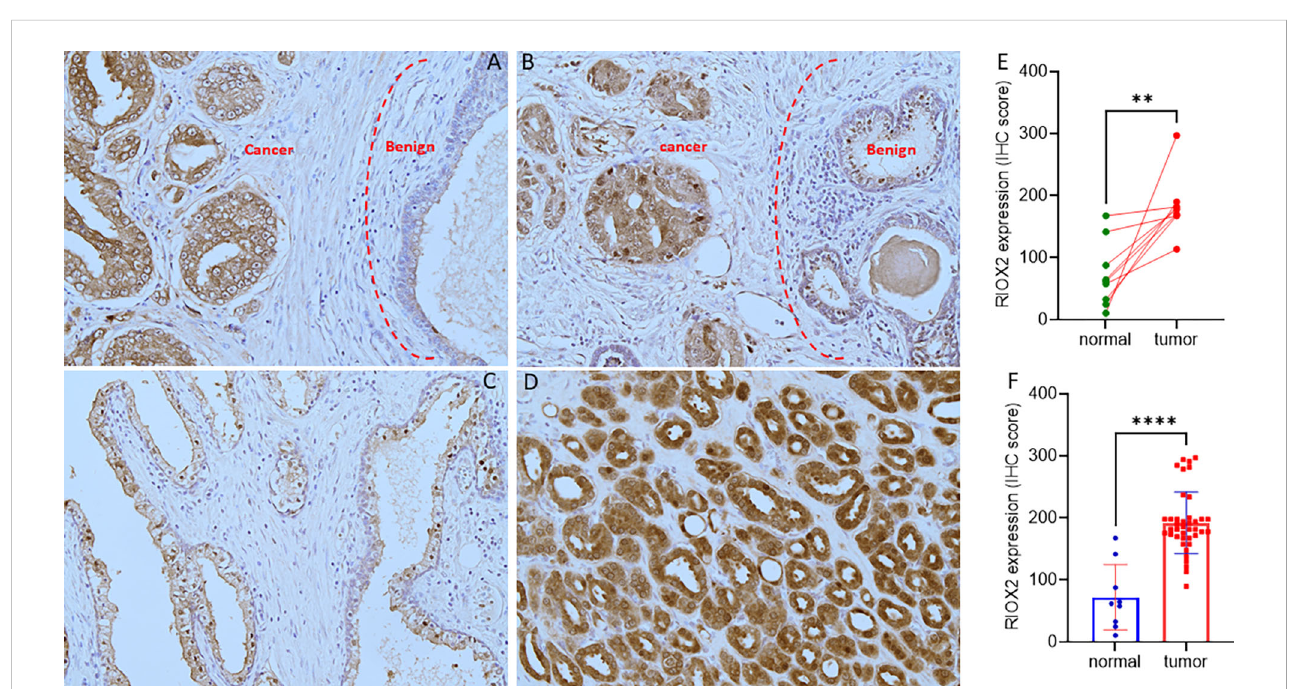
FIGURE 2 RIOX2 protein expression is increased in prostate cancer tissues. RIOX2 protein expression was examined in prostate cancer tissues with an IHC approach, as described in our recent publication (19). Representative microscopic images were shown from selected tissue sections with benign (A – C) and malignant compartments (A, B, D) . Magni fi cation x 200. Semi-quantitative data (MEAN and SEM) of the immunosignals were shown for the pairwise (E) or group cohort comparison (F) . The asterisk indicates a signi fi cant difference (Student t -test, **p < 0.01, ****p < 0.0001).